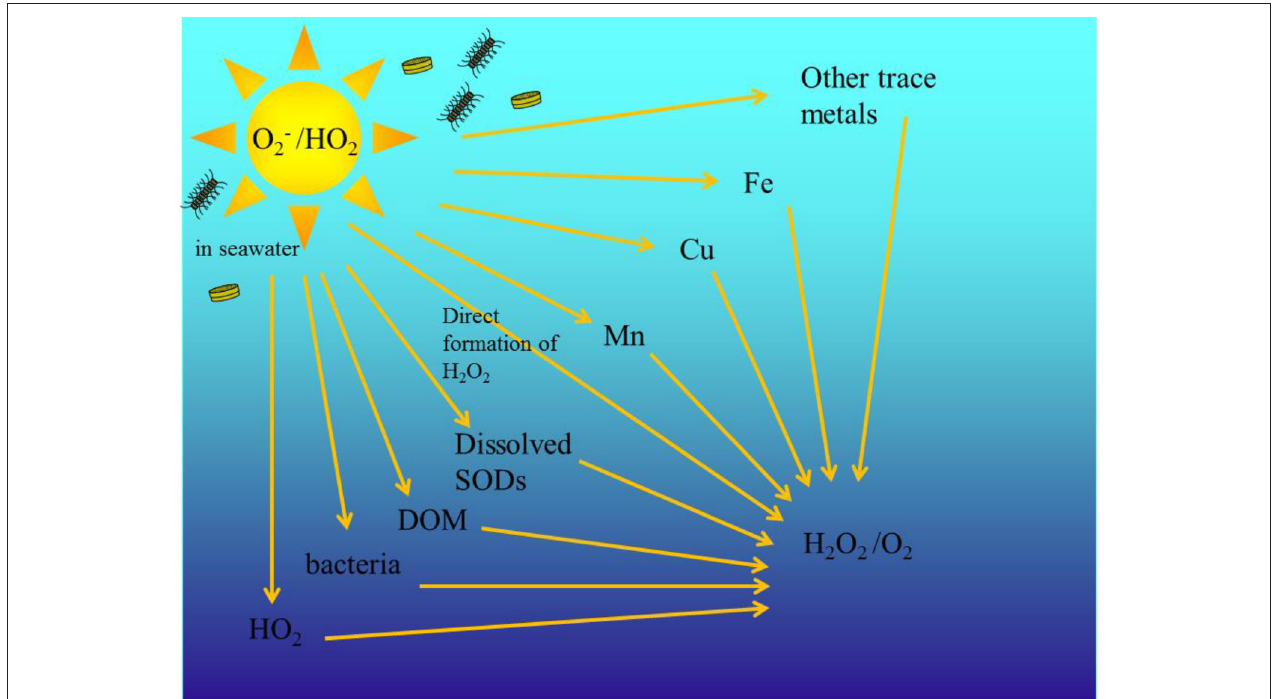
FIGURE 1 | Schematic of the different decay pathways for O − 2 decay in the ocean. O − 2 is biologically and photo produced. Modified from Wuttig et al.